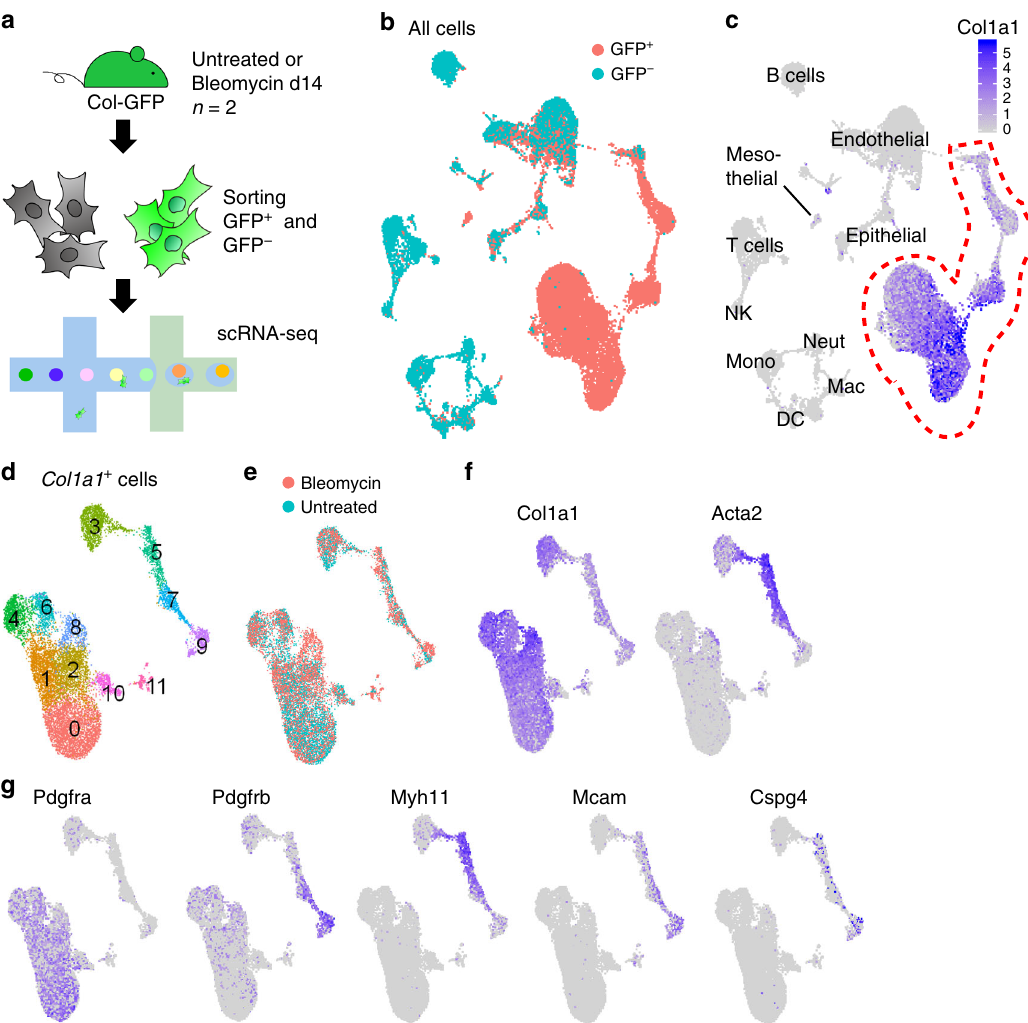
Fig. 1 scRNA-seq of murine lung cells in normal and fi brotic lungs. a Schematic of scRNA-seq sample preparation. b Uniform manifold approximation and projection (UMAP) plot of all cells colored by GFP + and GFP − samples. c Col1a1 expression on UMAP plot of all cells. See Supplementary Fig. 1a for identifying the lineages. NK, natural killer cell; Neut, neutrophil; Mac, macrophage; DC, dendritic cell; Mono, monocyte. d – f UMAP plots of Col1a1 + cells. d Unsupervised clustering identi fi es 12 clusters. e Cells from bleomycin-treated lung are shown in red. Cells from untreated lungs are shown in blue. f , g Gene expression levels for each